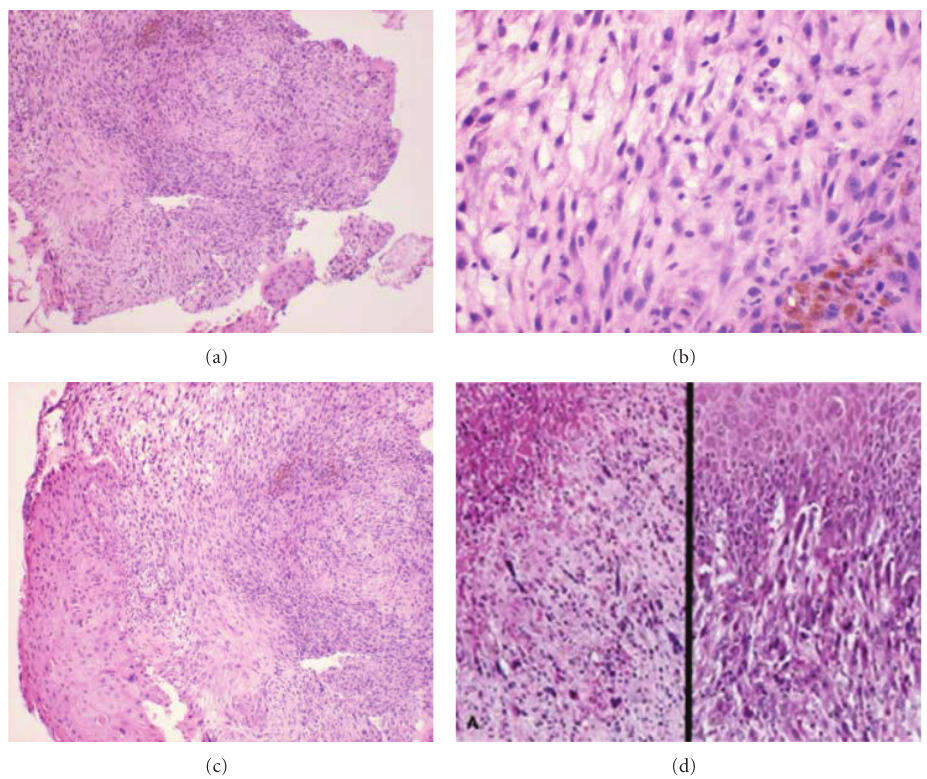
Figure 2: Histological findings: loose myxomatous fibrous connective tissue containing both spindle-shaped cells as well as ovoid cells with hyperchromatic, pleomorphic nuclei with eosinophilic cytoplasm. In some areas, cells assumed a whirling interlacing pattern and at one margin dysplastic-stratified squamous epithelium characterized by cells with pleomorphic hyperchromatic nuclei.